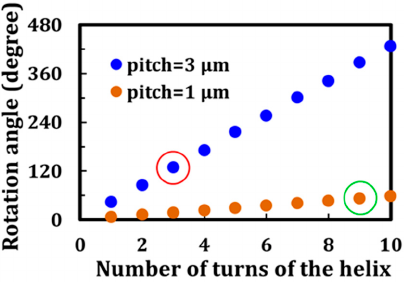
Figure 7. Simulation results for the rotation angle of the polarization as a function of the number of turns of the helix confined within a glass cell. Table 3. DoLP (degree of linear polarization) values for all the data shown in Figure 7. Pitch of 1 μ m